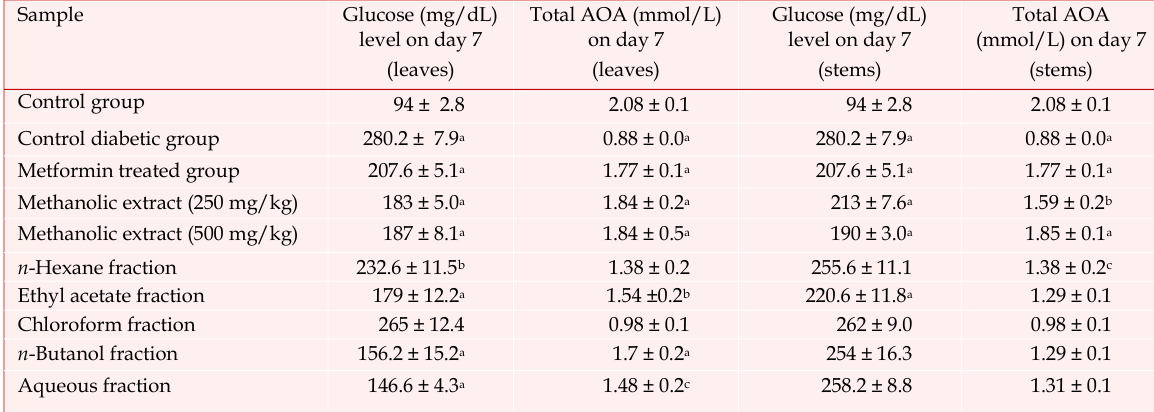
Effect of various fractions of L. pulverulentus ( D. sissoo) leaves and stems on glucose and total anti-oxidant activity in alloxan-treated diabetic